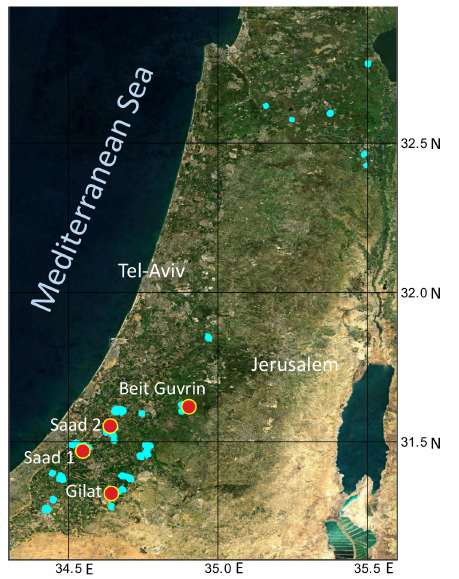
Figure 1. Location of fields that were included in this study (blue) and those that are mentioned in the manuscript